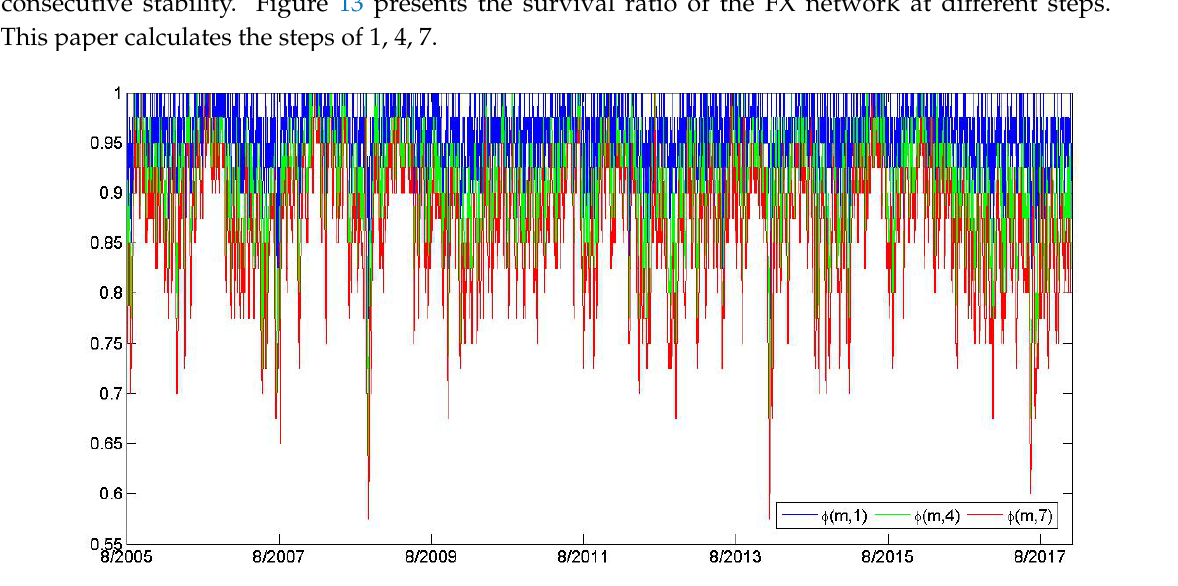
The Quantity of ρ ( k , σ ) ρ ( s , σ ) ρ ( b , σ )